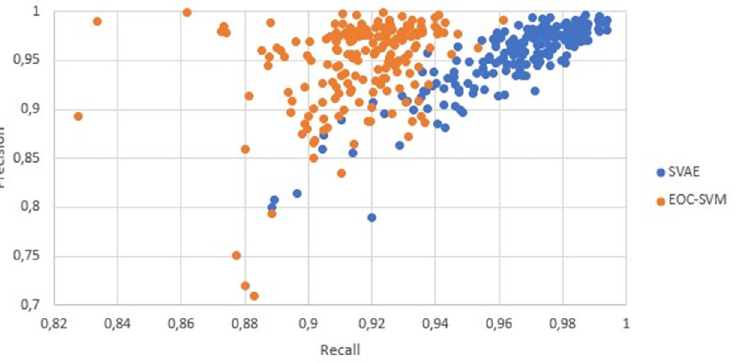
Fig 4. General comparison of precision and recall between the proposed SVAE (blue) and the EOC-SVM baseline (orange) over the 183 event collections.